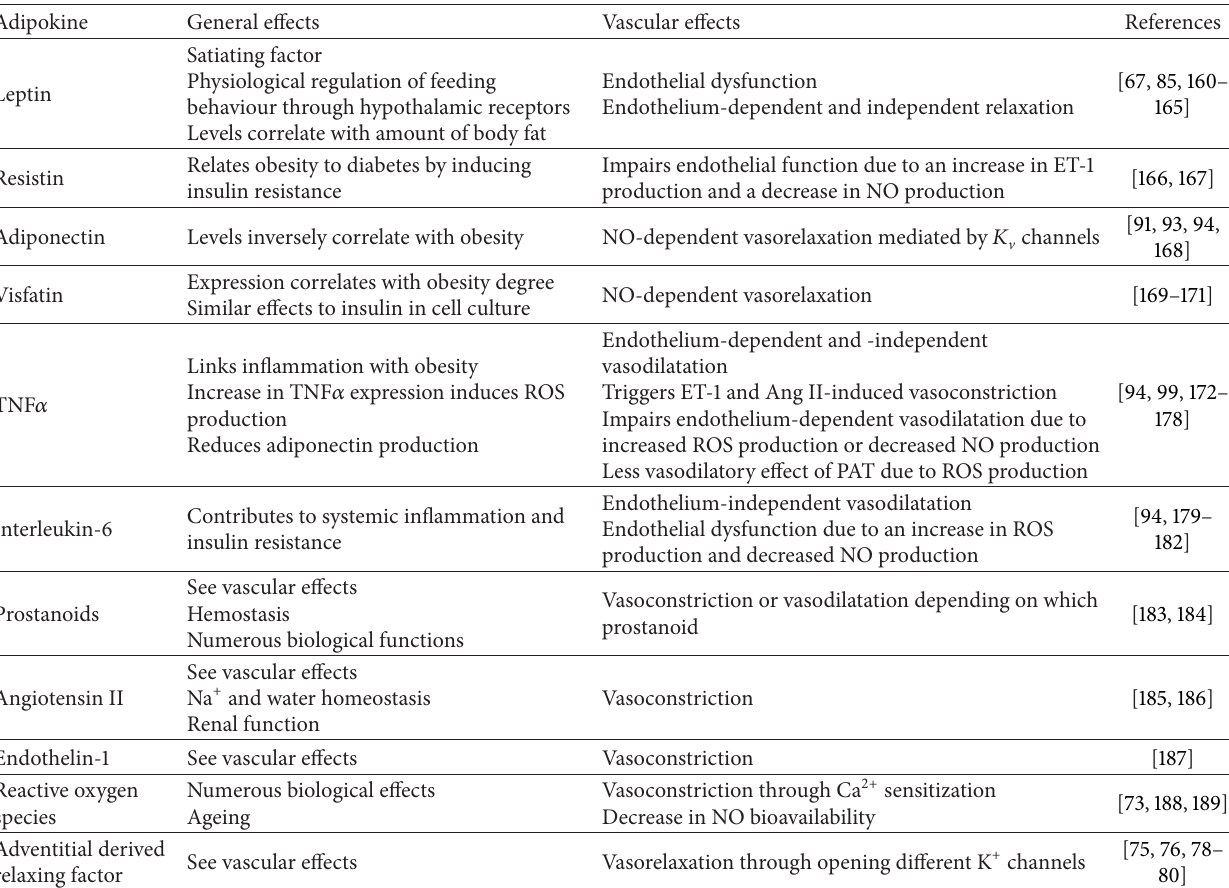
Table 1: Endocrine and vascular paracrine functions of some